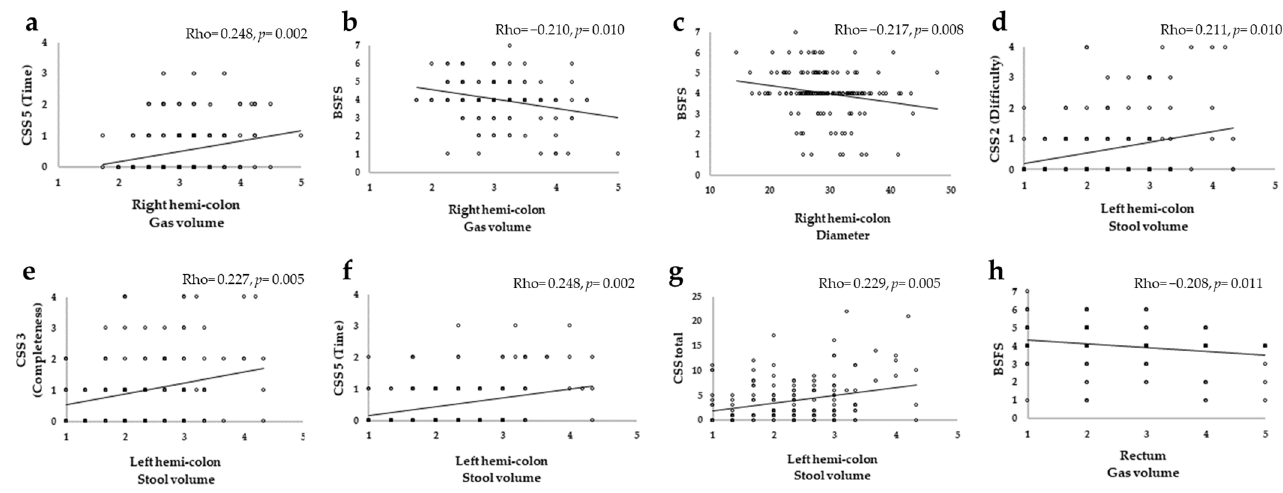
Correlation coefficient Rho ( p -value): Rho < − 0.20 or Rho > 0.20 with * p < 0.05 indicates a significant difference. CSS, Constipation Scoring System; BSFS, Bristol Stool Form Scale.